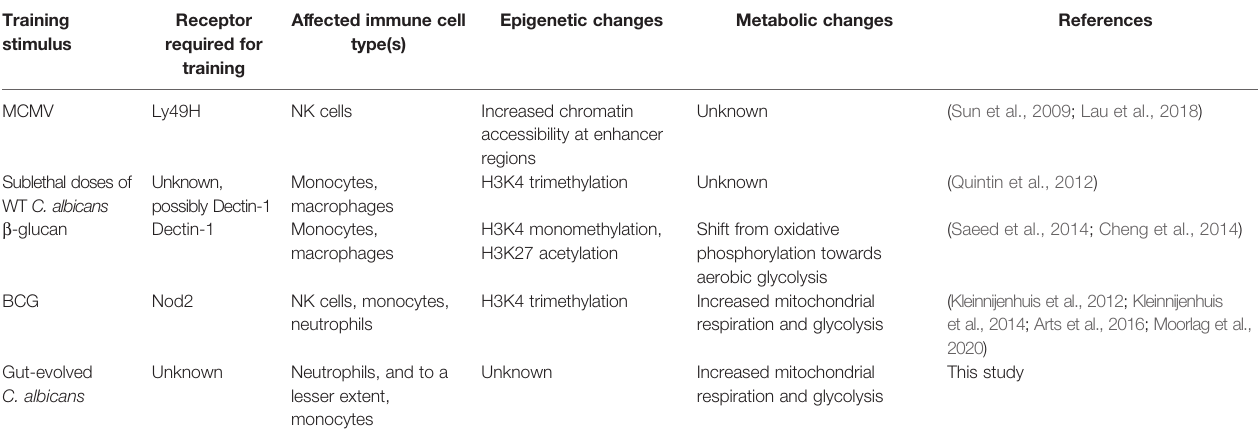
TABLE 1 | Examples of different stimuli inducing different trained immunity pathways.